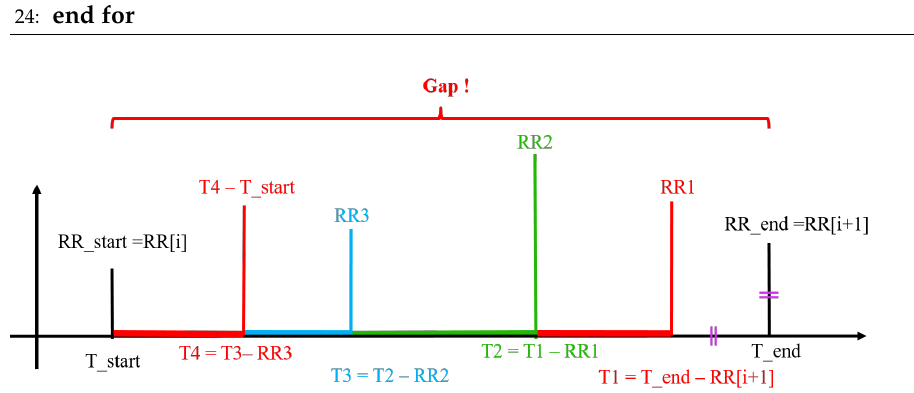
Figure 4. Data imputation using the DVC method. In the first iteration, T 1 is computed and RR 1 is randomly generated. This same process is repeated until T 4 − T start < 1.3 s and the last RR is the time difference between the last two